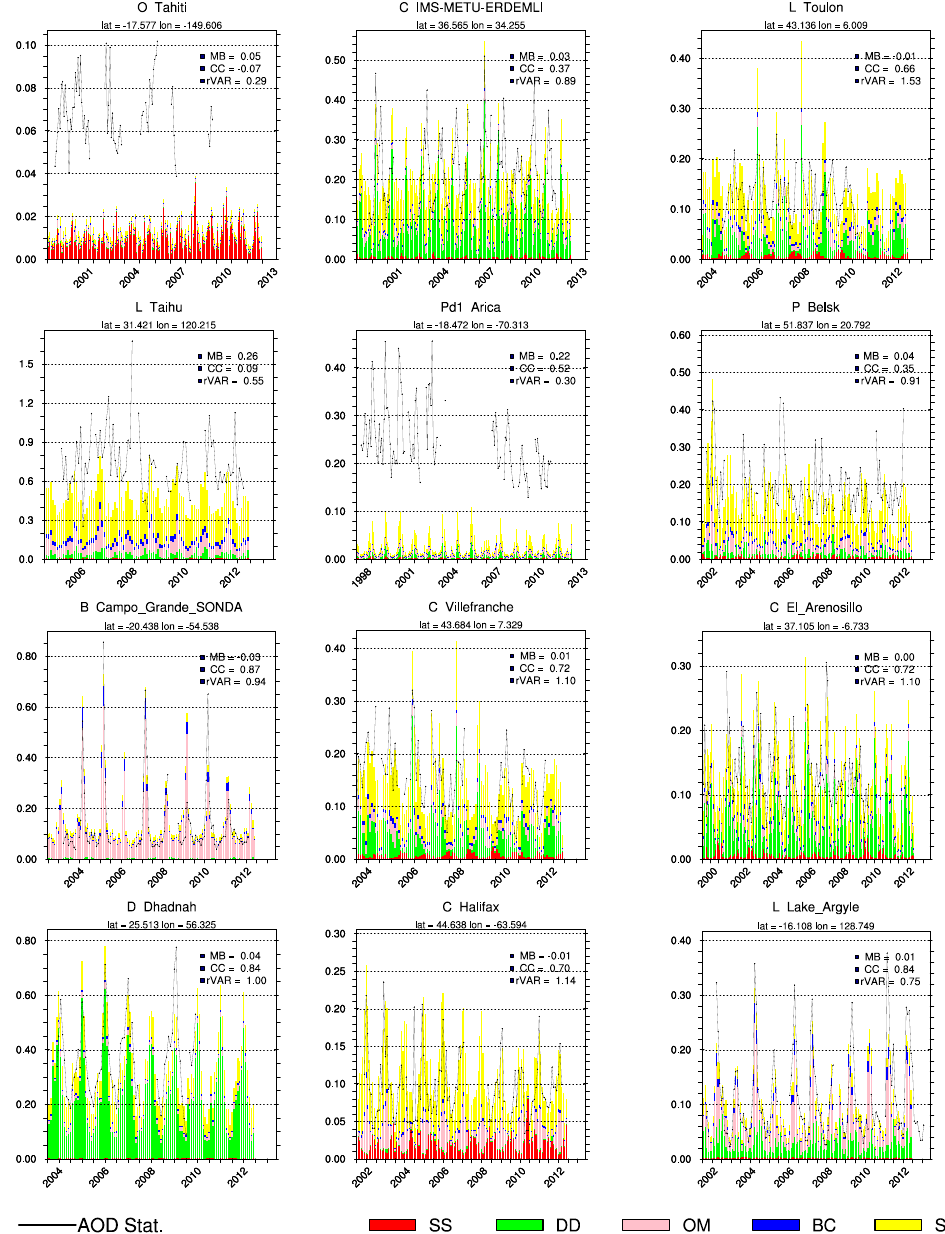
Figure 15. Times series of monthly AODs for a selection of poorly performing AERONET stations, first six images, and of well-performing AERONET stations, last six images, according to the Taylor diagram of Fig. 14. The same AODs as in Fig. 13 are shown. rVAR: ratio of observed versus modelled standard deviations, CC: correlation coefficient between observed and modelled time series, and MB: mean bias.